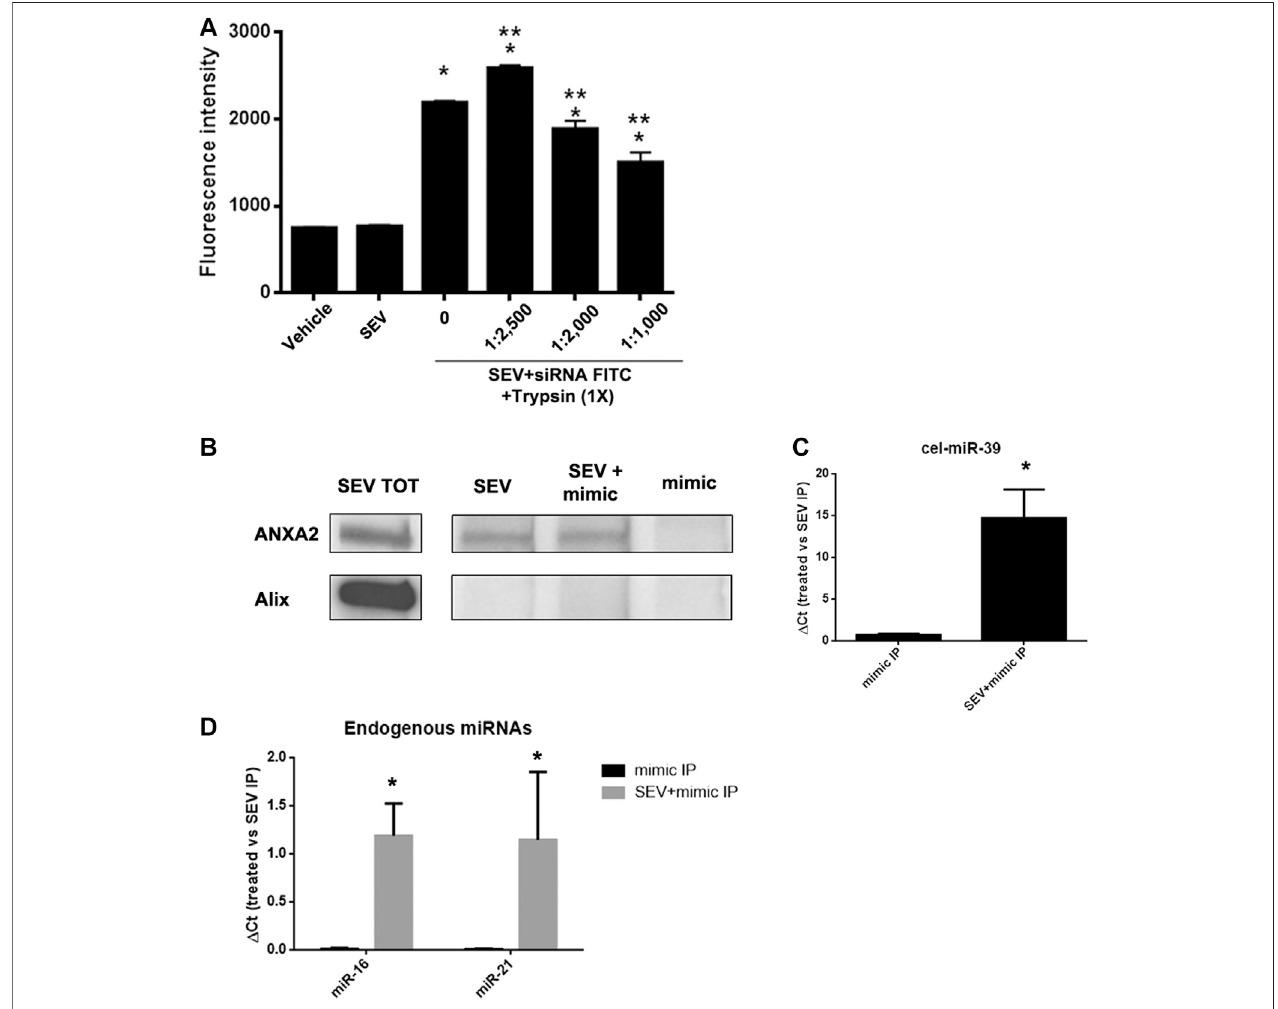
FIGURE4| SEVsbindingtoexogenousmimicismediatedbyproteins. (A) SEVsloadedwithsiRNA-FITCweretreatedwithdifferenttrypsinconcentration(1:1,000 to 1:2,500) for 1 h at 37 C. Fluorimetric analysis were conducted. Data are expressed as fl uorescence intensity ± SD the following: *p < 0.05 vs. SEV; **p < 0.05 vs. no trypsin treatment (0). (B) ANXA2 western blot analysis of SEVs (SEV), SEV + cel-miR-39 and cel-miR-39 samples, immunoprecipitated for ANXA2. Speci fi city of the IP procedure was validated by testing ALIX protein presence in the IP. Total protein extract (SEV TOT) was used as positive control for antibody speci fi city. (C) RepresentativeRealtimePCRanalysisofcel-miR-39expressiondetectedinSEV+cel-miR-39andcel-miR-39,immunoprecipitatedforANXA2(treated:SEV+mimicIP and mimic IP, respectively); * p < 0.05 vs mimic IP. (D) Expression of endogenous miR-16 and miR-21 detected in SEV+mimic IP and mimic IP, immunoprecipitated for ANXA2. In all the experiments SEV IP for ANXA2 was used as control. Data are expressed as 2- Δ Ct, where Δ Ct (cid:1) [Ct (treated) - (S EV IP)] ± SD; * p < 0.05 vs. mimic IP.